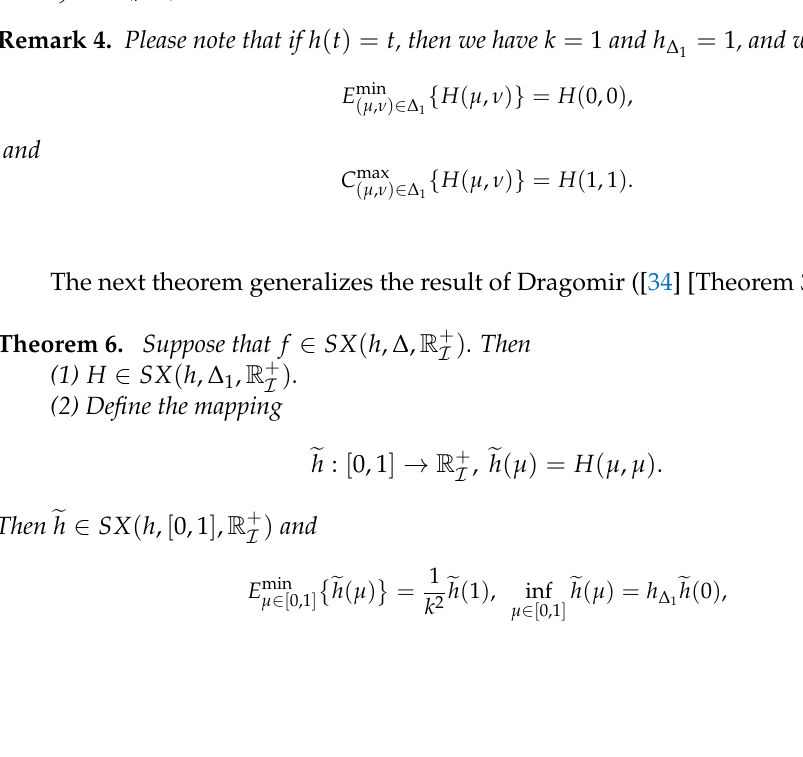
√ (cid:104) (cid:105) s 2 t 2 ,8 st , ( µ , ν ) ∈ ∆ 1 = [ 0,1 ] × [ 0,1 ] . then (cid:17) . From the above graph of the function H ( µ , ν ) , we